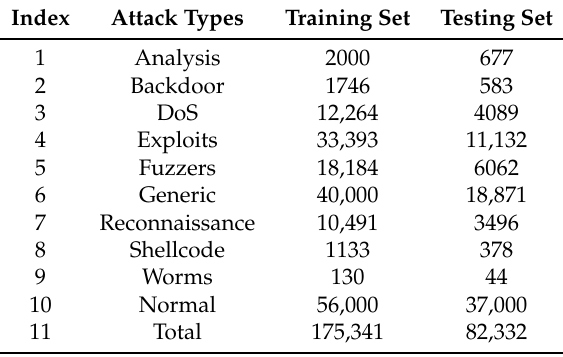
Table 6. Details of the UNSW_NB15